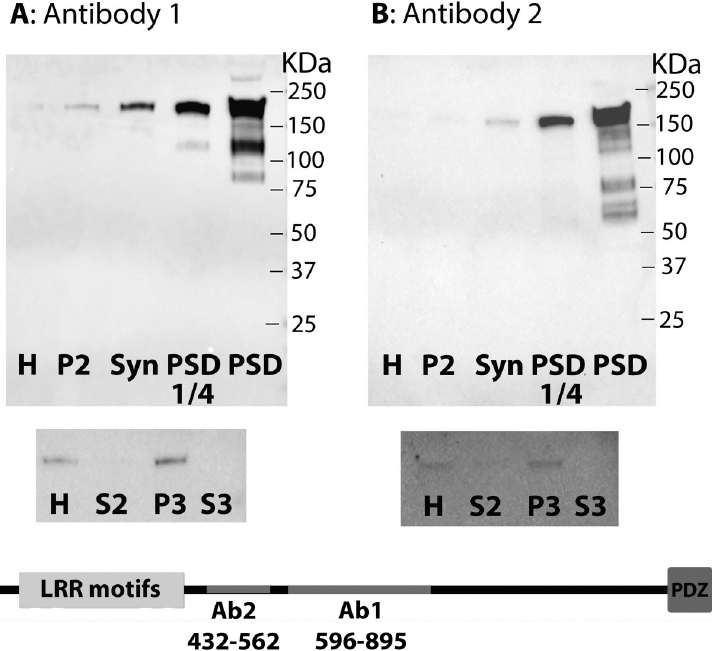
Fig 1. Distribution of densin in subcellular fractions from rat cerebral cortex. Western immunoblots using antibody 1 ( A ) or antibody 2 ( B ) show enrichment of densin in the PSD fraction. All lanes contain 20 μ g of protein except ‘PSD ¼ ’ which contains 5 μ g. Last lanes on the right: signal at the major ~180 KDa band is over-saturated allowing visualization of the lower molecular weight bands. H (homogenate), P2 (pellet after 10,500gX12min centrifugation), Syn (synaptosome), PSD (postsynaptic density). Middle panels: A slight enrichment in the light membrane fraction (P3) as compared to homogenate is observed, while the cytosol fraction (S3) does not show detectable signal. Bottom: Graphical depiction of densin molecule with LRR motifs at the N-terminal and a PDZ domain at the C-terminal. The peptide sequences used to generate antibody 1 (Ab1) and antibody 2 (Ab2) are located in the middle region between these N-and C-terminal